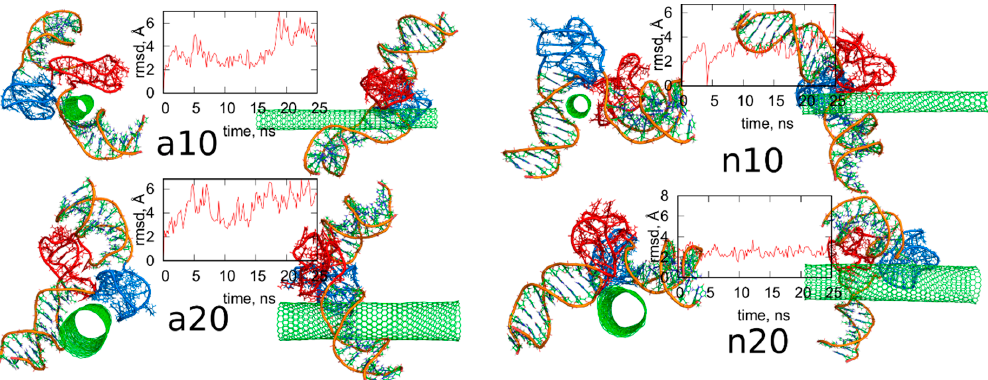
Figure 7. Simulation snapshots of the systems from Figure 4 after removal of guanine functional groups from fCNT and the rmsd plots of iG parts calculated for the next 25 ns of simulations. The reference configurations for calculation of rmsd were just the structures from Figure 4. The snapshots taken at the very last simulations timesteps. Each of these configurations is available in the supplementary material as pdb files, files fig7_a10.pdb, fig7_a20.pdb, fig7_n10.pdb, fig7_n20.pdb. Int. J. Mol. Sci. 2020 , 21 , x FOR PEER REVIEW